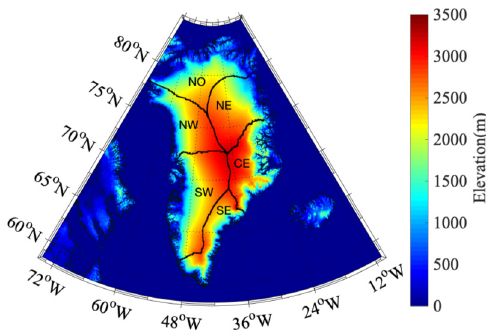
Figure 1. Topography of Greenland. Black lines delineate the boundaries of each discharge basin.